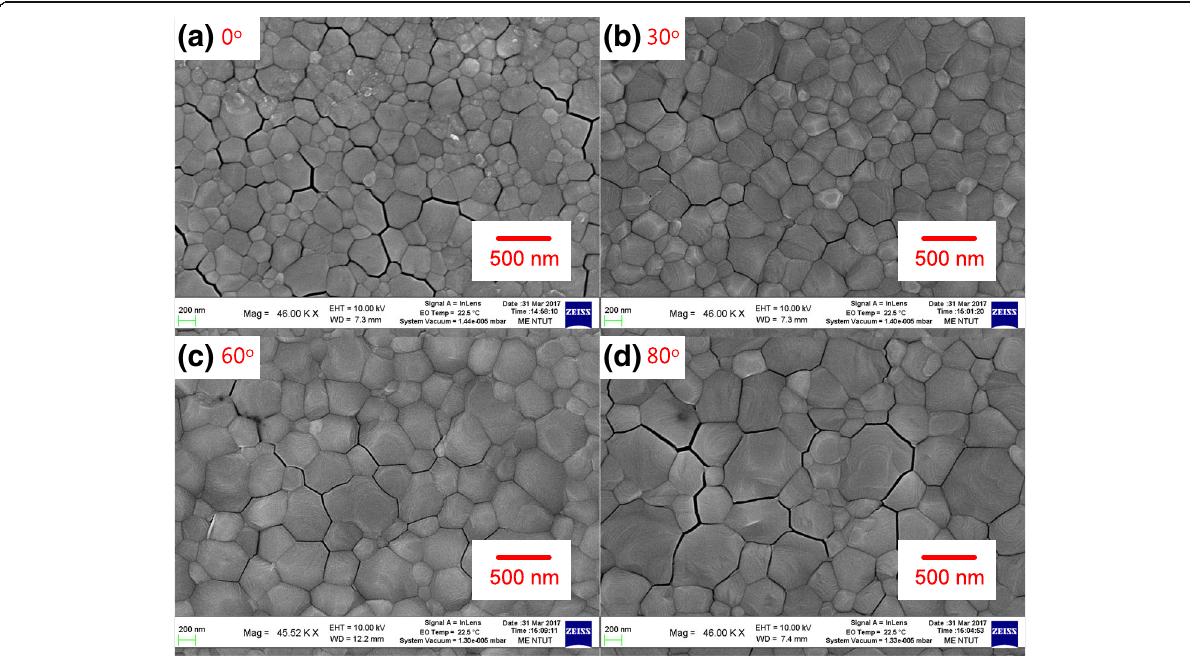
Fig. 3 a – d SEM images of MAPbI 3 perovskite films on PEDOT:PSS/oblique ITO layer/glass for various oblique angles